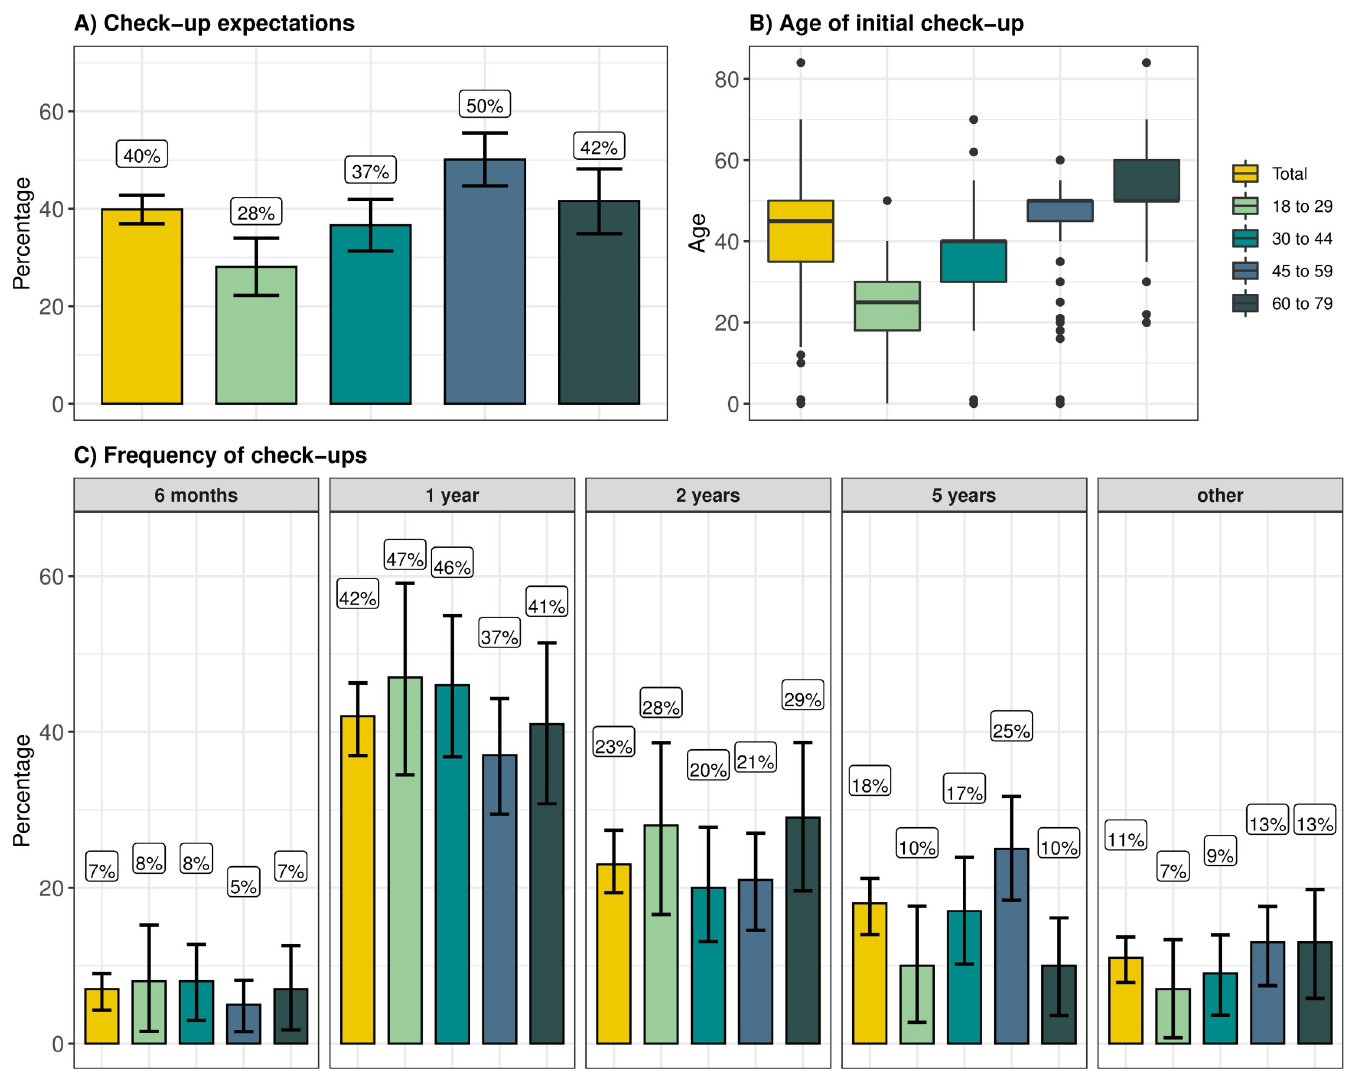
Fig 2. Check-up expectations per age groups and total. A) Percentage of respondents who indicated they expected check-up examinations in addition to regular care per age and in total. B) Age of initial check-up routine expected in each age group and in total. C) Frequency of expected check-ups per age group and in total. Response options were every 6 months, each year, every two years, every five years, once, or other. No respondent chose the option ‘once’, therefore this is not shown in the figure.